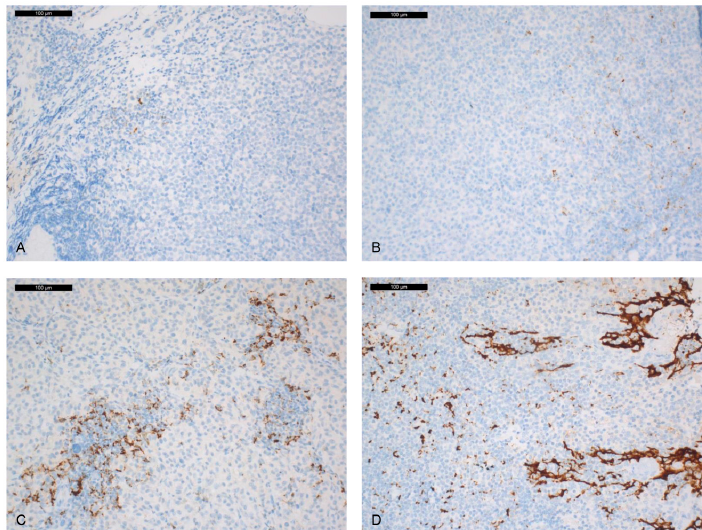
Figure 1. PD-L1 expression in immune cells with the SP142 clone (the panels with different percentages of PD-L1 expression in IC are representative of images showing similar results). ( A ) rare IC staining (1%). ( B ) focal IC staining (5%). ( C ) moderate IC staining (20%). ( D ) positive control (immuno-peroxidase; original magnification ×200). Int. J. Mol. Sci. 2020 , 21 , x FOR PEER REVIEW